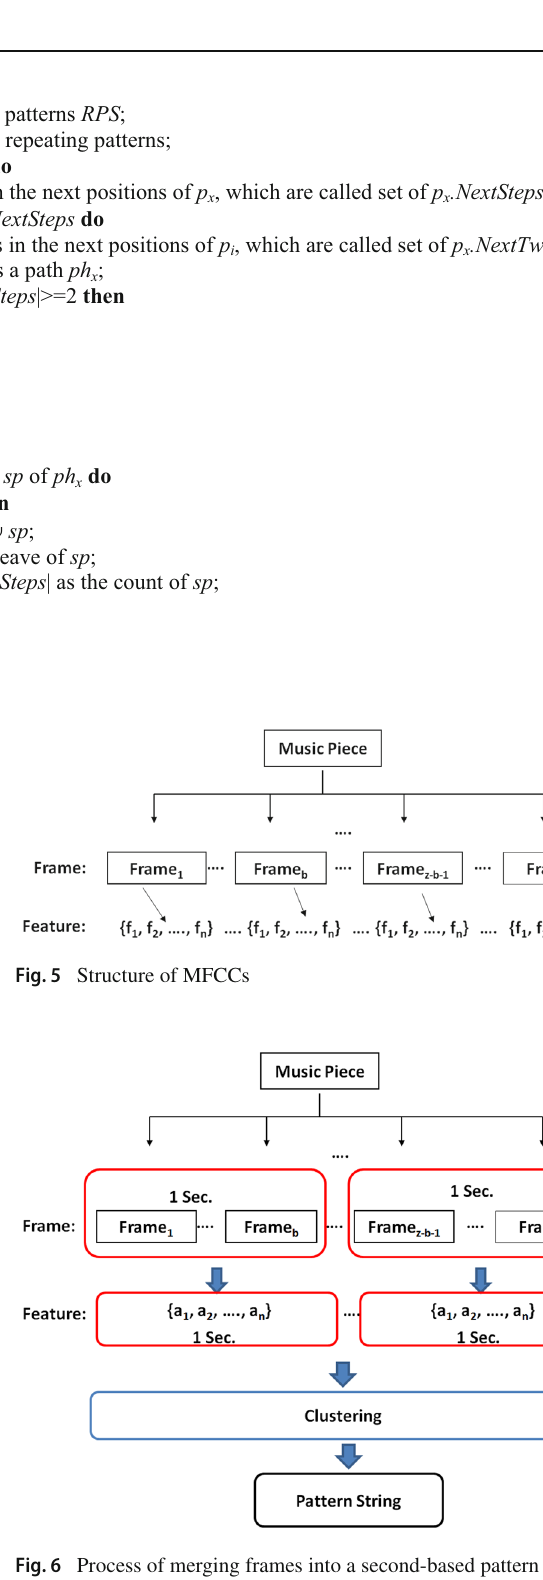
ters. Then, each second-based feature vector is encoded by the cluster number, and finally, a music piece is transformed into a pattern